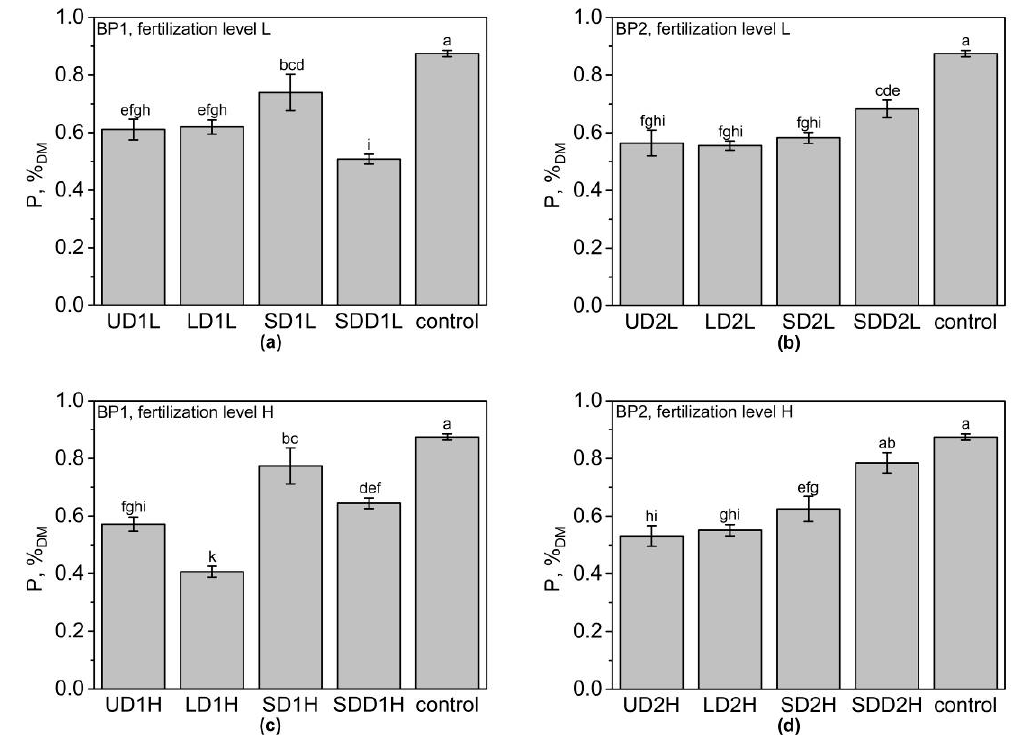
Figure 4. Phosphorus content %P of above-ground biomass for different treatments: ( a ) Treatments based on manure as feedstock from BP1 with fertilization level L; ( b ) Treatments based on energy crops as feedstock from BP2 with fertilization level L; ( c ) Treatments from BP1 with fertilization level H; ( d ) Treatments from BP2 with fertilization level H; (code see Table 1; n = 4, whiskers show standard deviation, different letters indicate significant differences, p = 0.05).